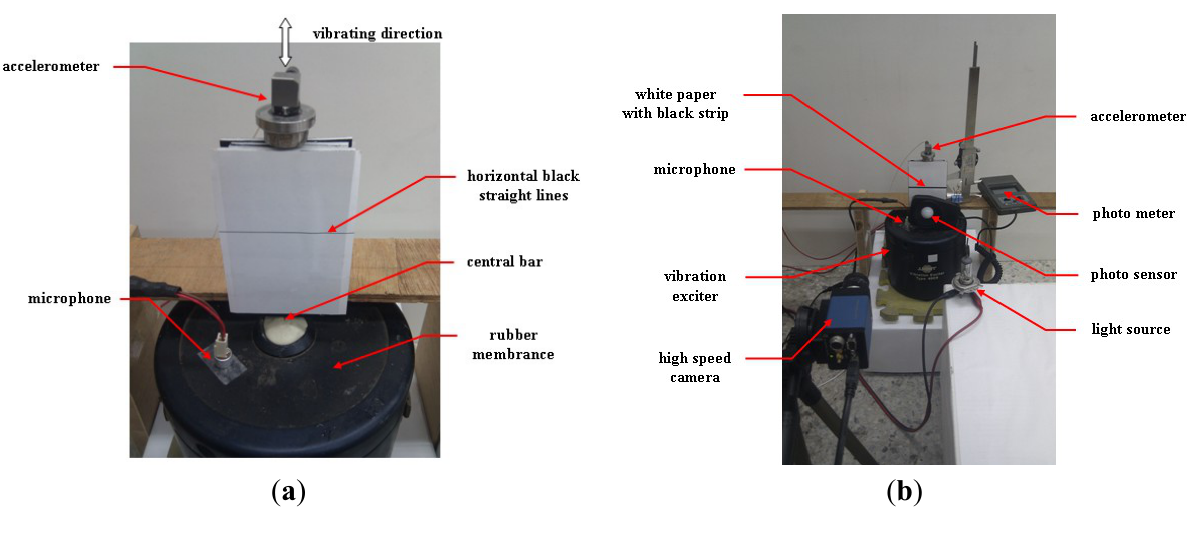
Figure 2. The experimental setup: ( a ) vibration exciter, accelerometer, and microphone. ( b ) overall